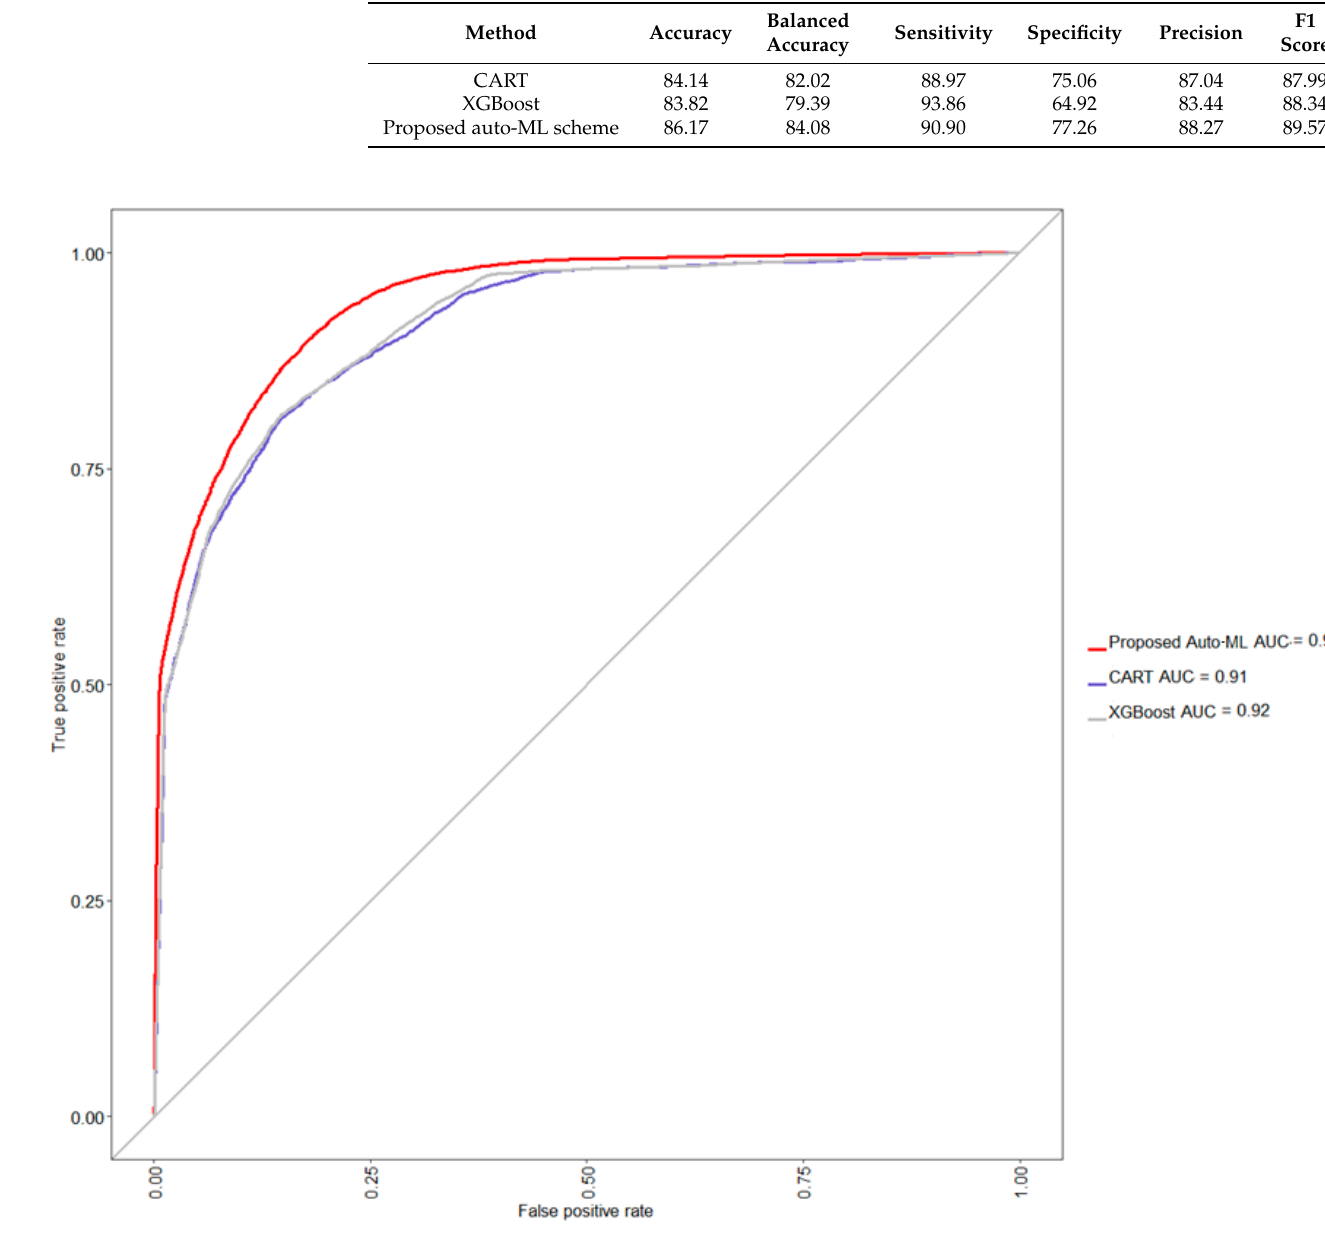
Table 3. The top 10 ranked feature importance for CKD third stage progression.